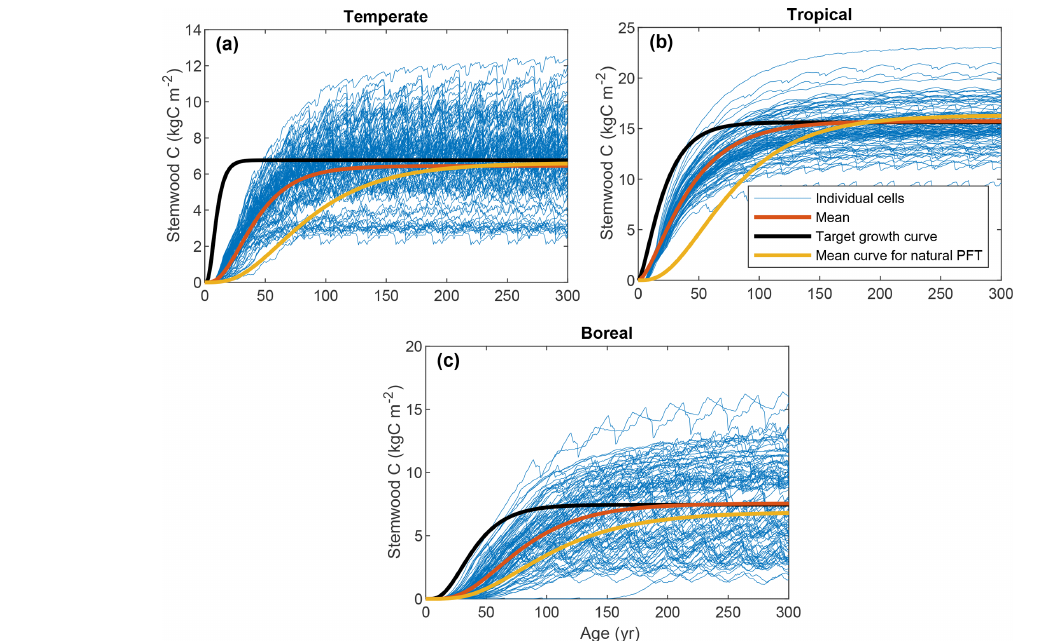
Figure 5. Predicted stemwood C for 100 calibration grid cells of each FPFT based on the optimal parameter sets. Note the different scales of the y